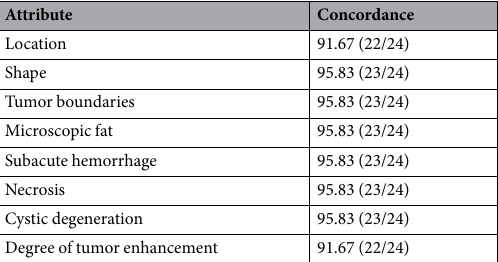
Table 4. Comparison of the Concordance between Readers for Each Assessed Qualitative Imaging Feature. Note: Values are percentages with raw numbers of patients (n) in